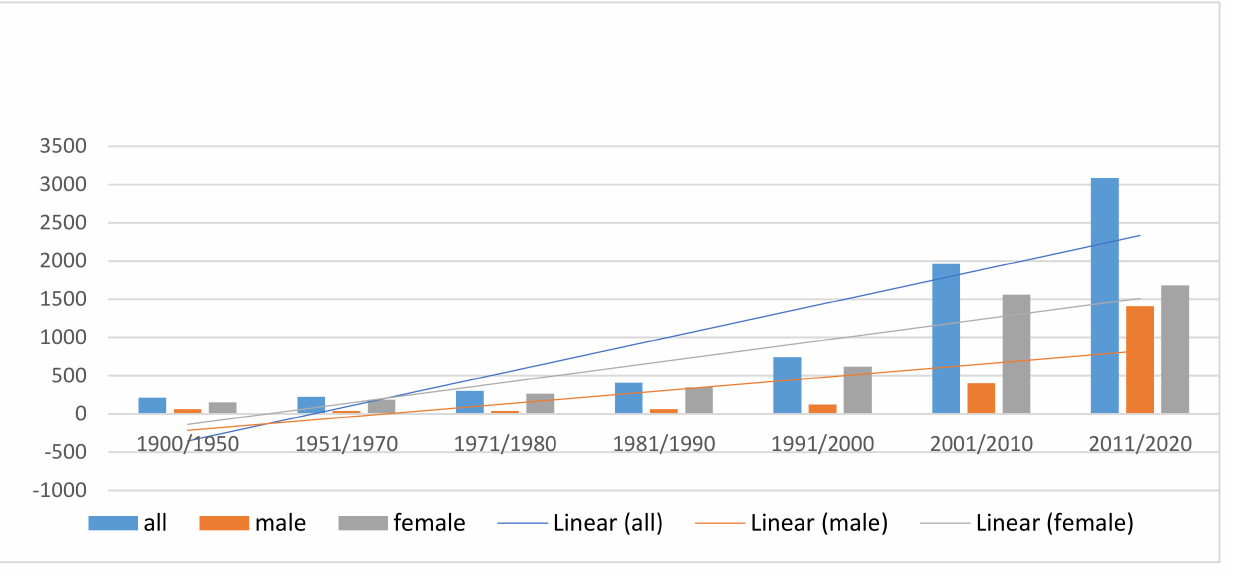
Figure 2. Trends in demography of the stud-book registered Murgese horses over the last century. Linear trend lines are represented using dotted lines whose color is consistent with the corresponding bar